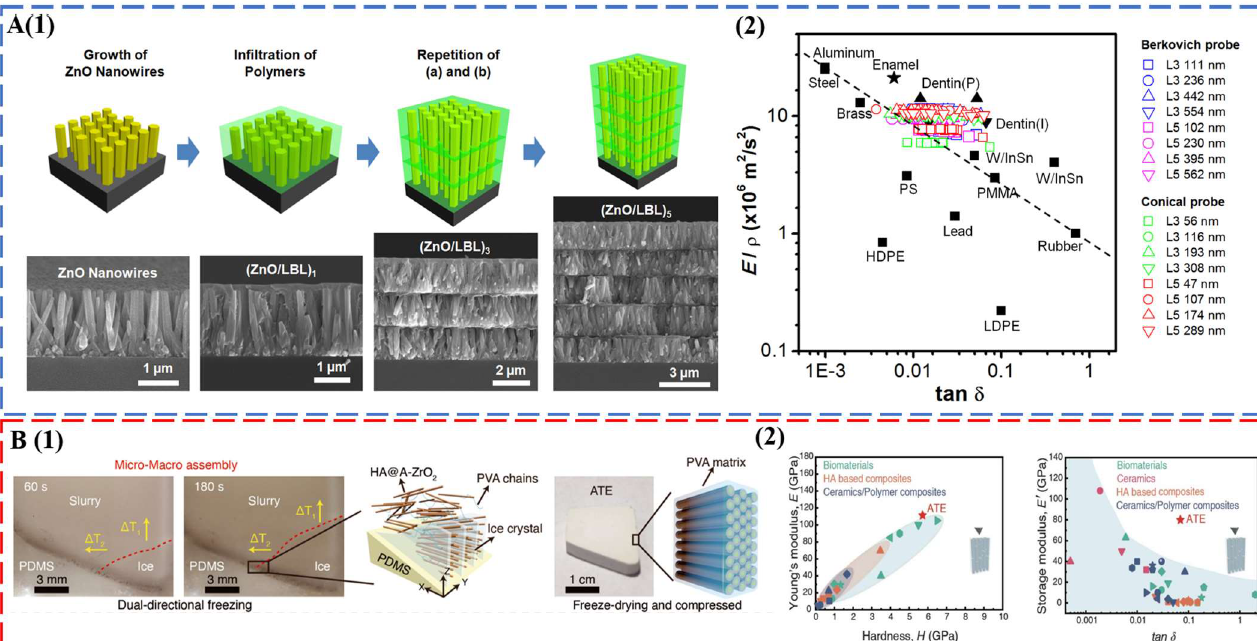
Figure 4. ( A ) Abiotic tooth enamel by LBL assembly. (1) Schematic illustration of the preparation and structure of columnar biomimetic composites produced by sequential LBL infiltration of ZnO nanowires with polymers. ZnO nanowires grown on an Si substrate. (2) Energy dissipation (tan δ ) and load-bearing characteristics ( E ′/ ρ ) of (ZnO/LBL) n compared to manufactured materials and bi- ocomposites. These figures from B. Yeom et al. [43] were kindly provided by Prof. Nicholas A. Ko-